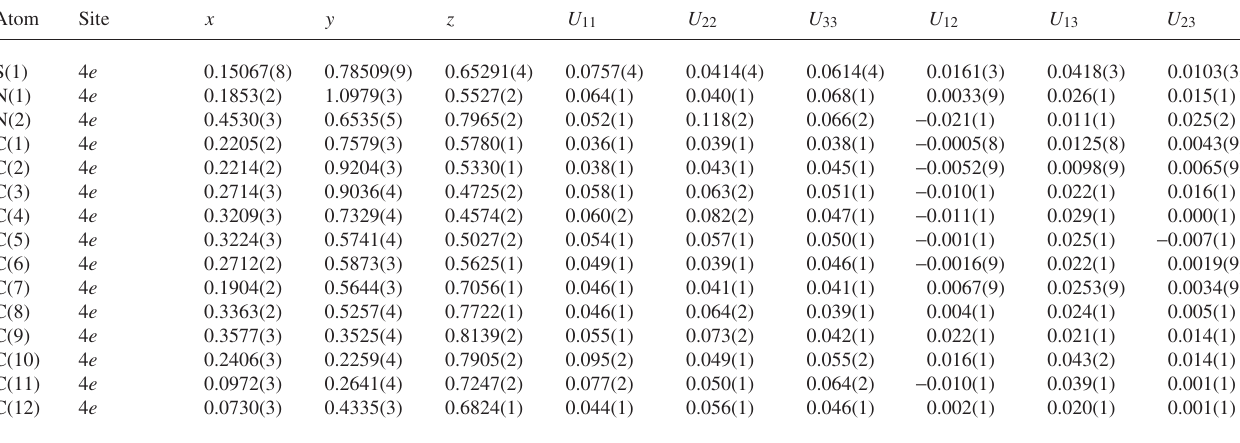
Table 3. Atomic coordinates and displacement parameters (in Å 2 )